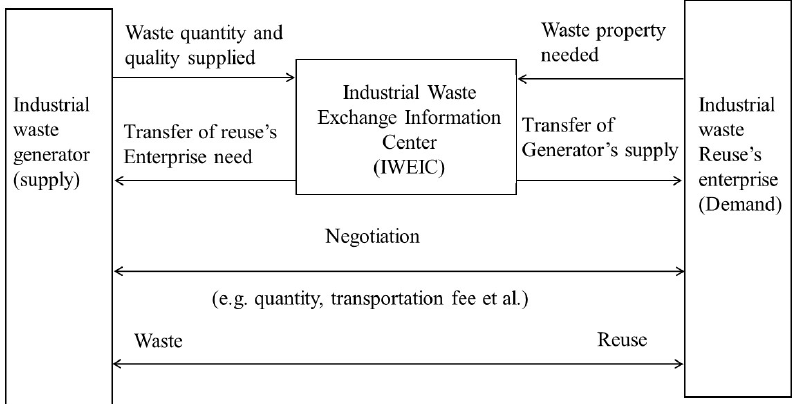
Figure 3. Exchange schematic of industrial waste developed by IWEIC, Taiwan